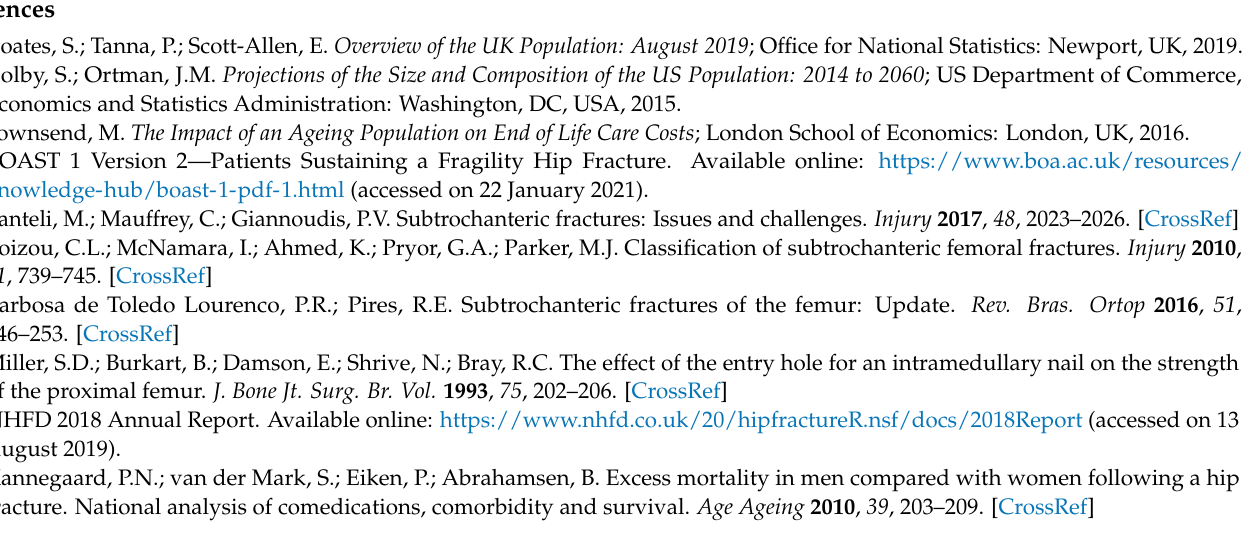
HDU: High dependency unit; ICU: Intensive care